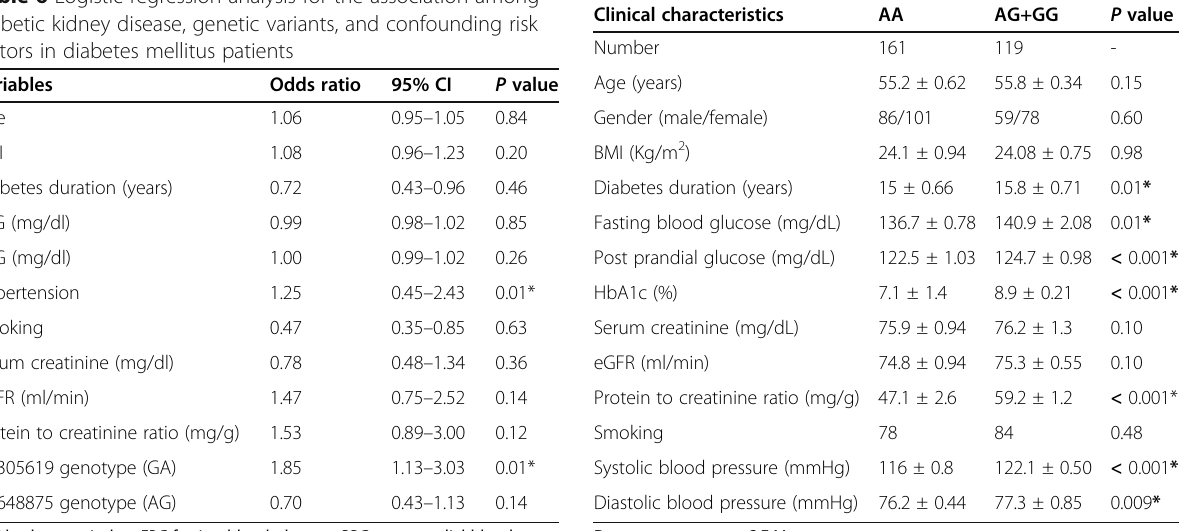
Table 7 Characteristics and clinical parameters of